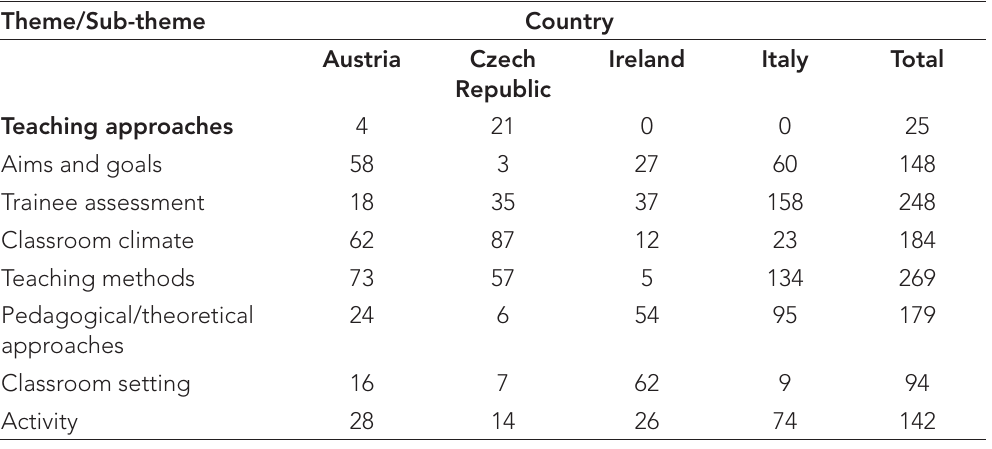
Table 3: Frequency of codes within theme ‘Teaching approaches’